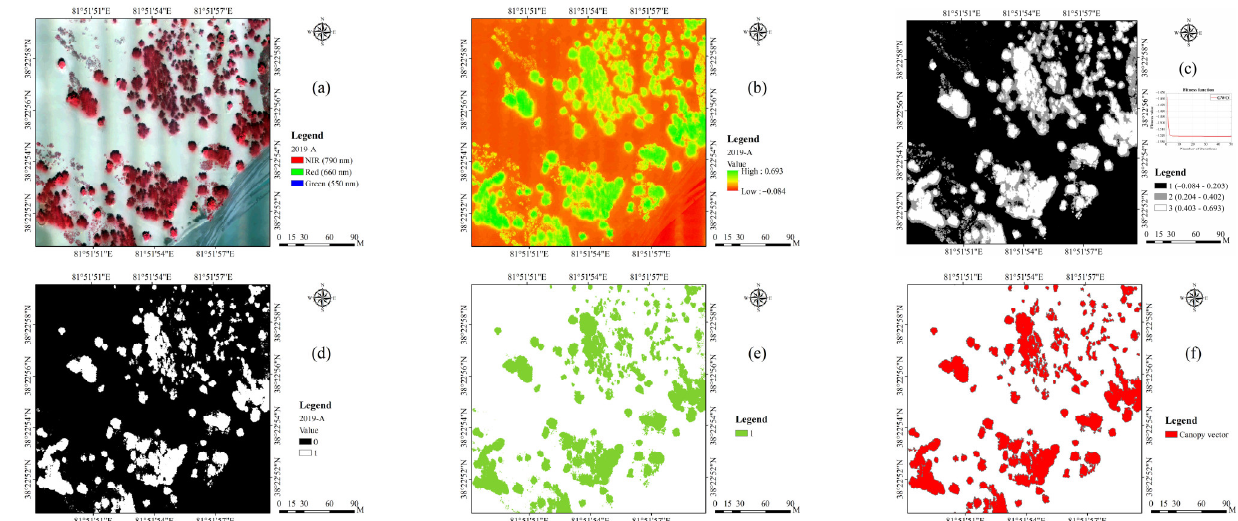
Figure 6. Schematic diagram of the GWO-OTSU multithreshold segmentation process for the 2019-A quadrat multispectral UAV image. ( a ) Parrot Sequoia+ UAV false-color synthetic multispectral image. ( b ) NDVI map generated from multispectral image. ( c ) The result of GWO-OTSU dual threshold segmentation based on NDVI map. ( d ) Binarization and filtering results of double threshold segmentation map. ( e ) 0-value nulling result of the filter map. ( f ) Vectorization diagram of Populus euphratica crown.